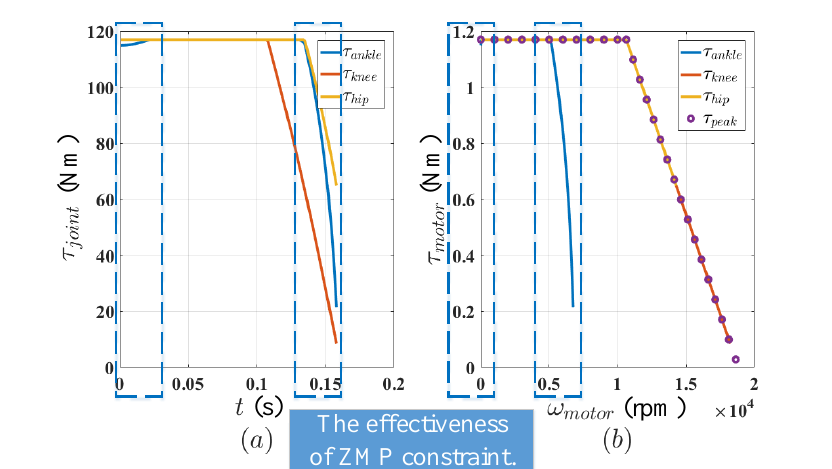
Figure 10. Assuming that X 0 = ( − 57 ◦ , 158 ◦ , − 126 ◦ , 0, 0, 0 ) , ( a ) shows the torque of each joint; and ( b ) represents relationships between the motor torque and speed. At the beginning of the jump motion, the ankle joint torque is slightly reduced to satisfy the ZMP constraint. Similar effectiveness can also be observed when the robot is about to take off.